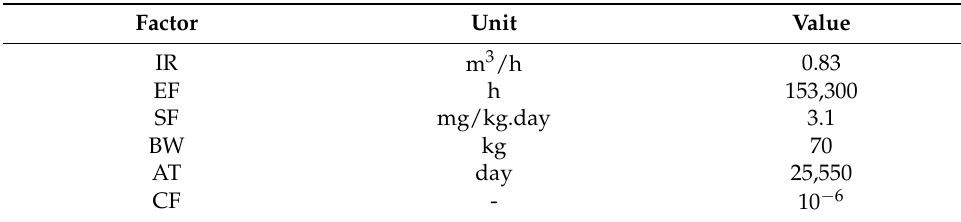
Table 3. Detailed information on incremental lifetime cancer risk (ILCR)